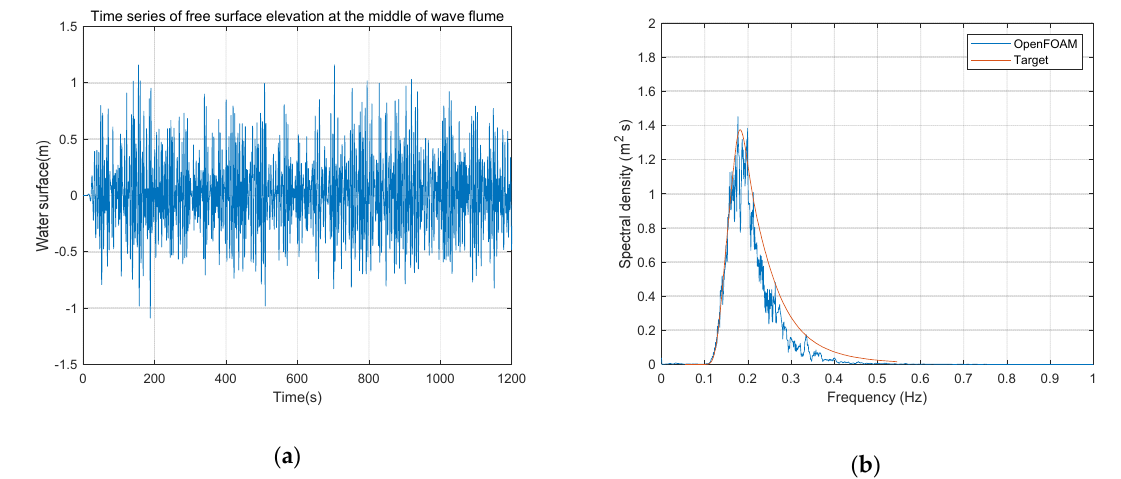
Figure 11. Irregular wave generation. ( a ) Time series of wave elevation and ( b ) wave spectral density. The extracted powers in response to increasing bi- and uni-directional PTO load torque at 𝐻 (cid:3046) = 0.75 m and 𝑇 (cid:3043) = 5.50 s were compared, as shown in Figure 12. The ex- tracted powers were averaged over 1100 s. The optimized uni-directional PTO load torque (9 kNm) was greater than the optimized bi-directional PTO load torque (3 kNm). The extracted power curve of a second-order polynomial at uni-directional PTO load torque is much smoother than that in the bi-direction. Both results are similar to the reg- ular wave test. This means that the extracted power with uni-directional PTO load is rel- atively insensitive to the PTO load torque variation than the bi-directional case.